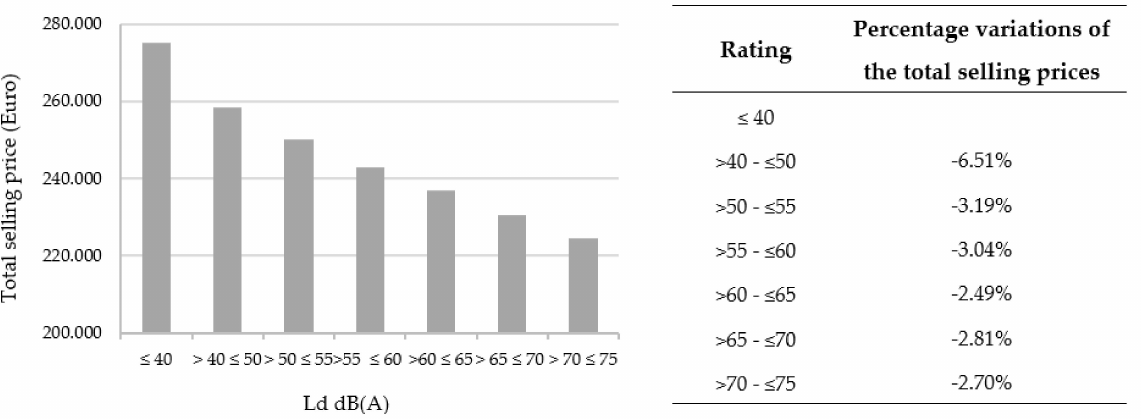
Figure 8. Functional relationship between the Ld label and the prices and percentage variations for the noise pollution class rating for the OMI semi-central area of the city of Bari.